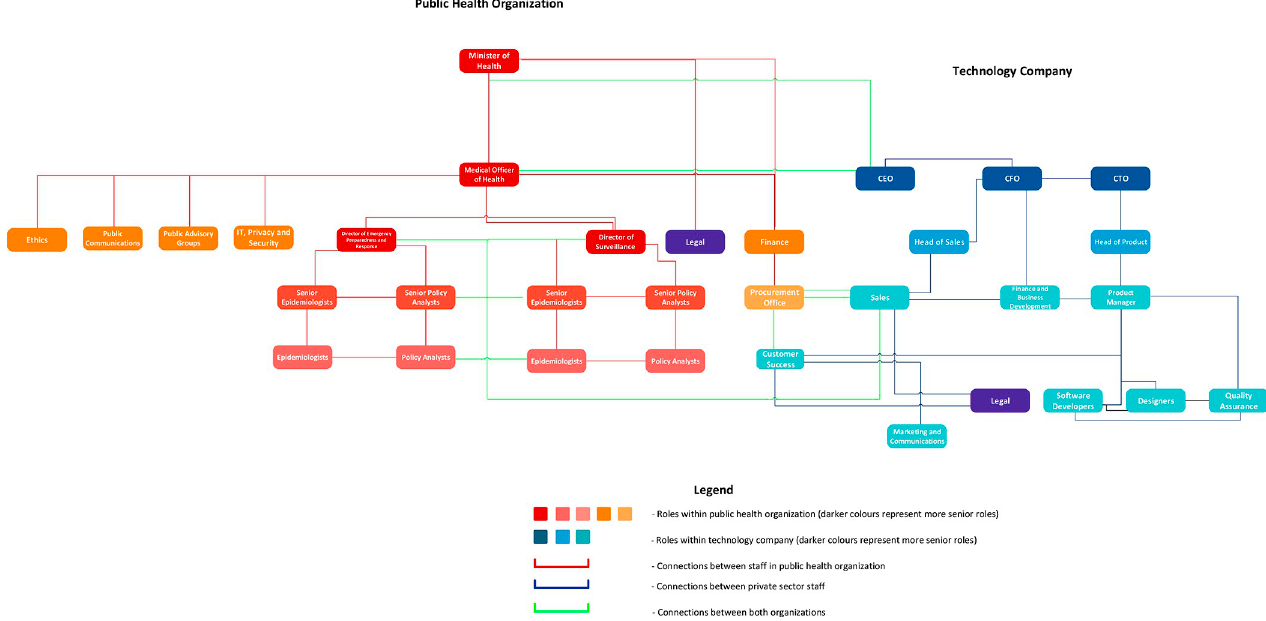
Fig 3. Generalized partnership logic diagram between technology companies and public health